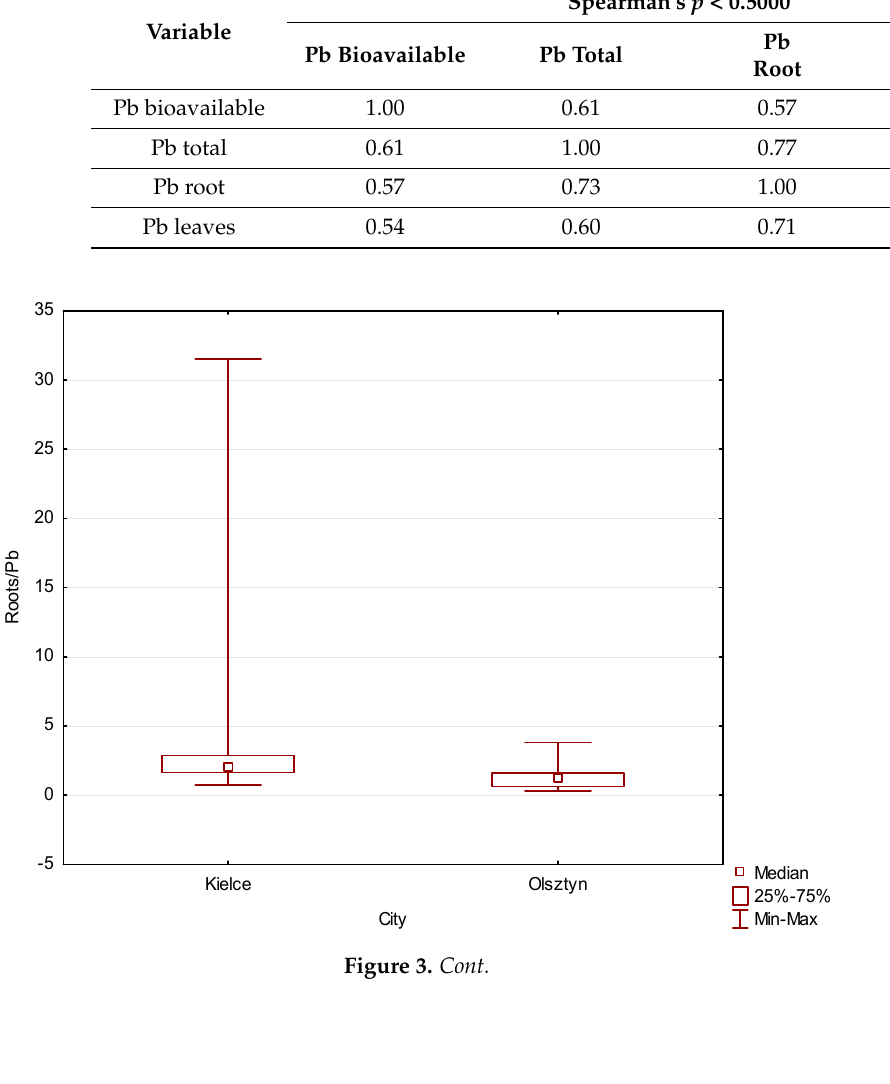
Table 10. Relationships between the content of lead in the soils and common dandelion. Variable